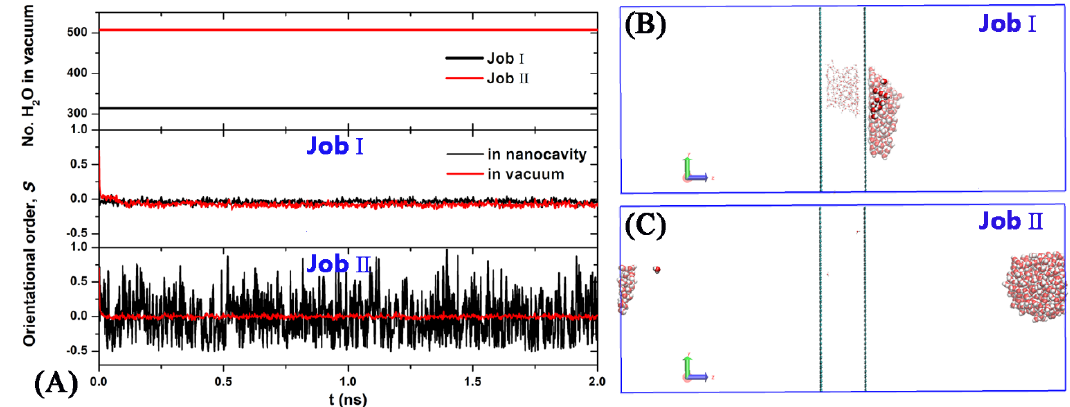
Figure 7. Time dependence of the number of water molecules in vacuum chamber and orientational order ( S ) of water molecules for Job I and Job II ( A ). The side view snapshot of the simulation system at 2 ns for Job I ( B ) and for Job II ( C